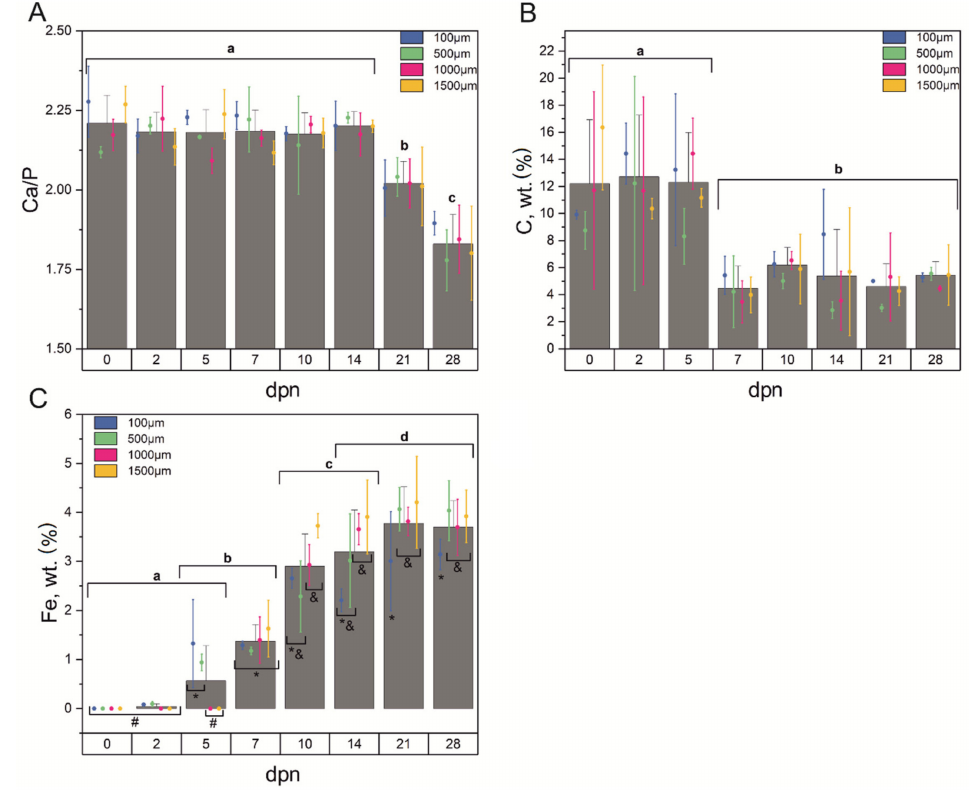
Figure 5. Ca/P ratio ( A ), carbon content ( B ) and iron concentration ( C ) based on EDS analysis determined for the 0th, 2nd, 5th, 7th, 10th, 14th, 21st and 28th day of postnatal life (columns) and 100 µ m, 500 µ m, 1000 µ m and 1500 µ m distance from the incisor tip (error bars plot) with corresponding statistics. Data are presented as mean ± SD. Different letters indicate significant differences in groups (at p < 0.05) for mean values and symbols (*, #, &) for iron concentration depending on the